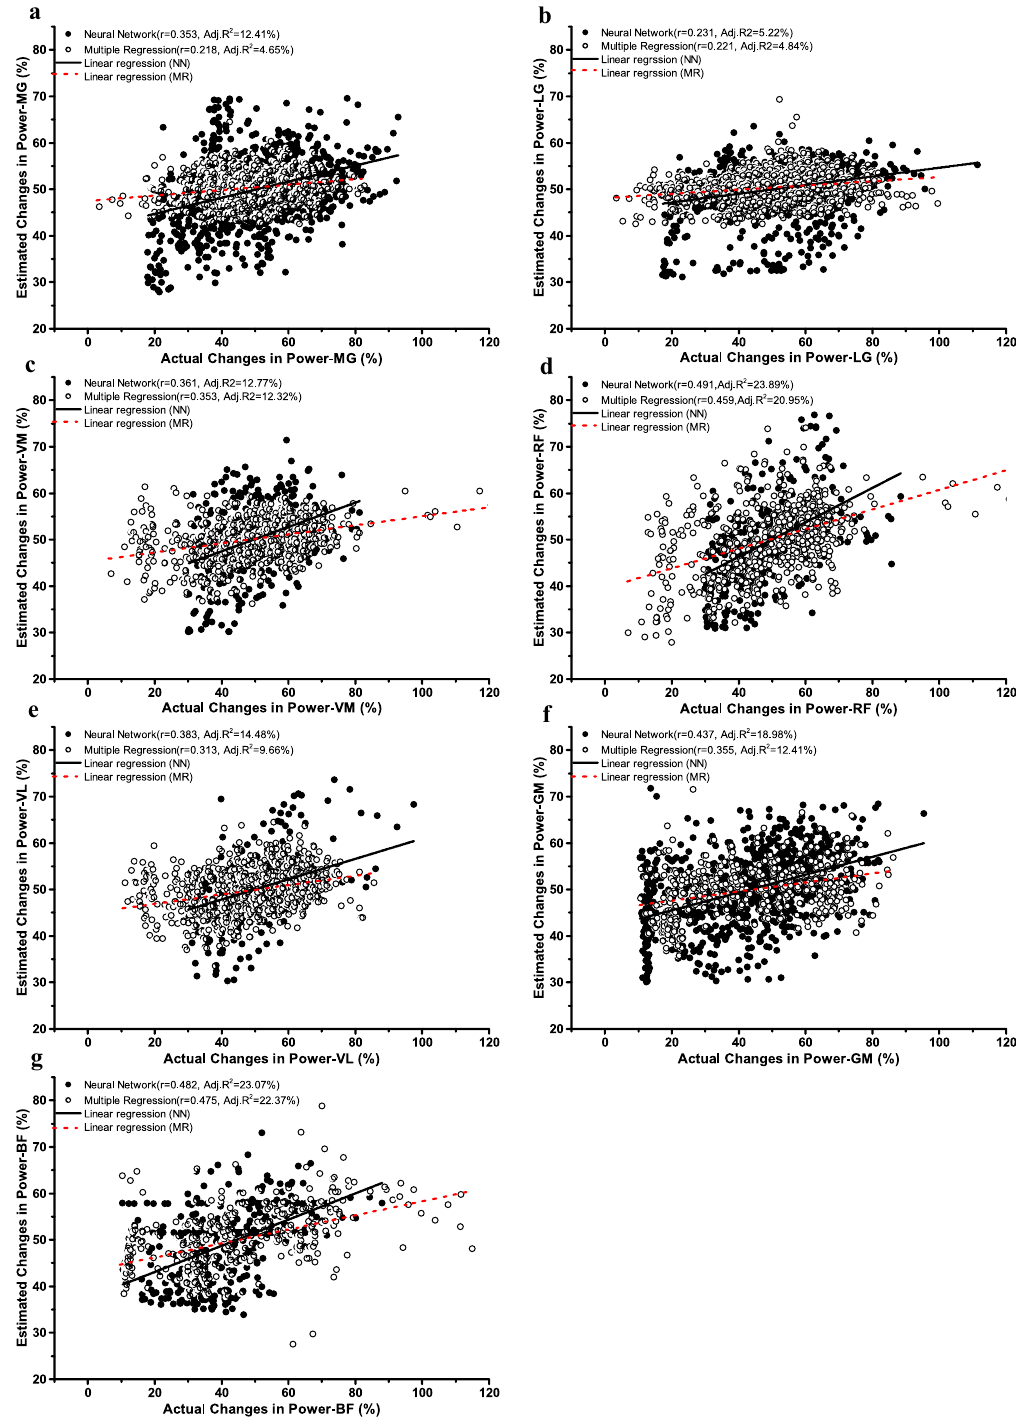
Figure 4. Actual changes versus estimated changes in peak power output obtained from both linear and non- linear models. Note : r pearson’s correlation coefficients, R 2 coefficient of determination. NN neural network, MR multiple regression. MG medial gastrocnemius, LG lateral gastrocnemius, VM vastus medialis, RF rectus femoris, VL vastus lateralis, GM gluteus maximus, BF biceps